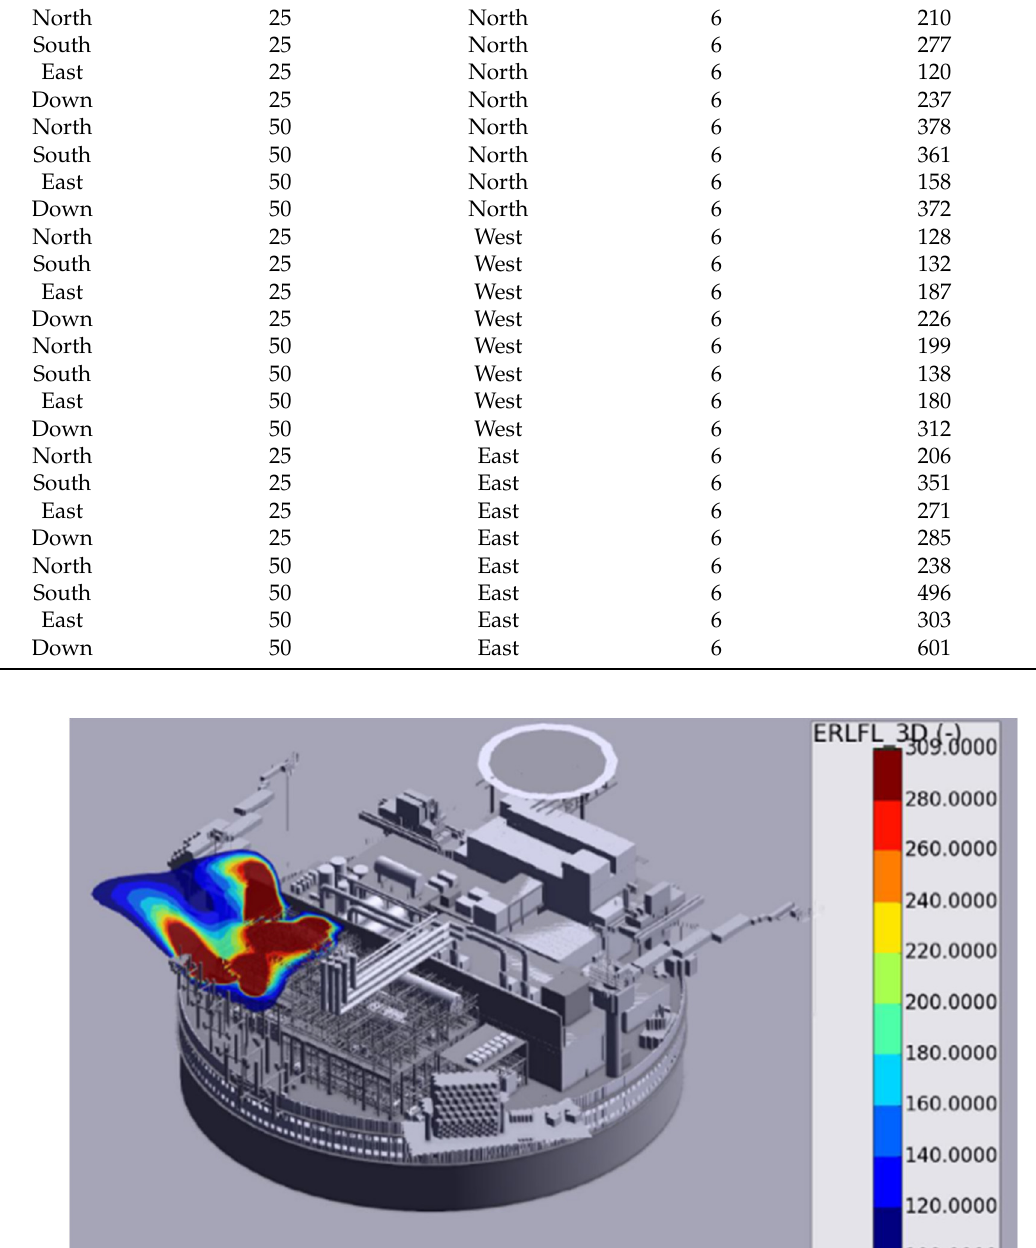
Figure 11. Gas cloud obtained for case 651,117. North leak direction, 25 kg/s leak rate, east wind direction, and 6 m/s wind speed. Figure 10 displays the dispersion simulation result of a leakage gas cloud under dis- persion case 661124. This result demonstrates that the gas cloud is mainly distributed in PR1_1st deck, PR1_2nd deck, and the firewall, especially in the process module region, where there is a large number of Q9 gas clouds. This gas cloud would gradually extend to offloading portside and the utility module due to the influence of the east wind. Simul- taneously, Table 3 demonstrates that this case would produce the maximum Q9 gas cloud volume of 601 m 3 , which was caused by the combined effect of downwards leakage and wind east direction. Looking at the leakage gas cloud under case 661,117, from Figure 11, it can be seen that this leakage gas cloud was mainly distributed in PR1_1st deck and PR1_2nd deck. Table 3 demonstrates that the Q9 gas cloud volume was 206 m 3 .